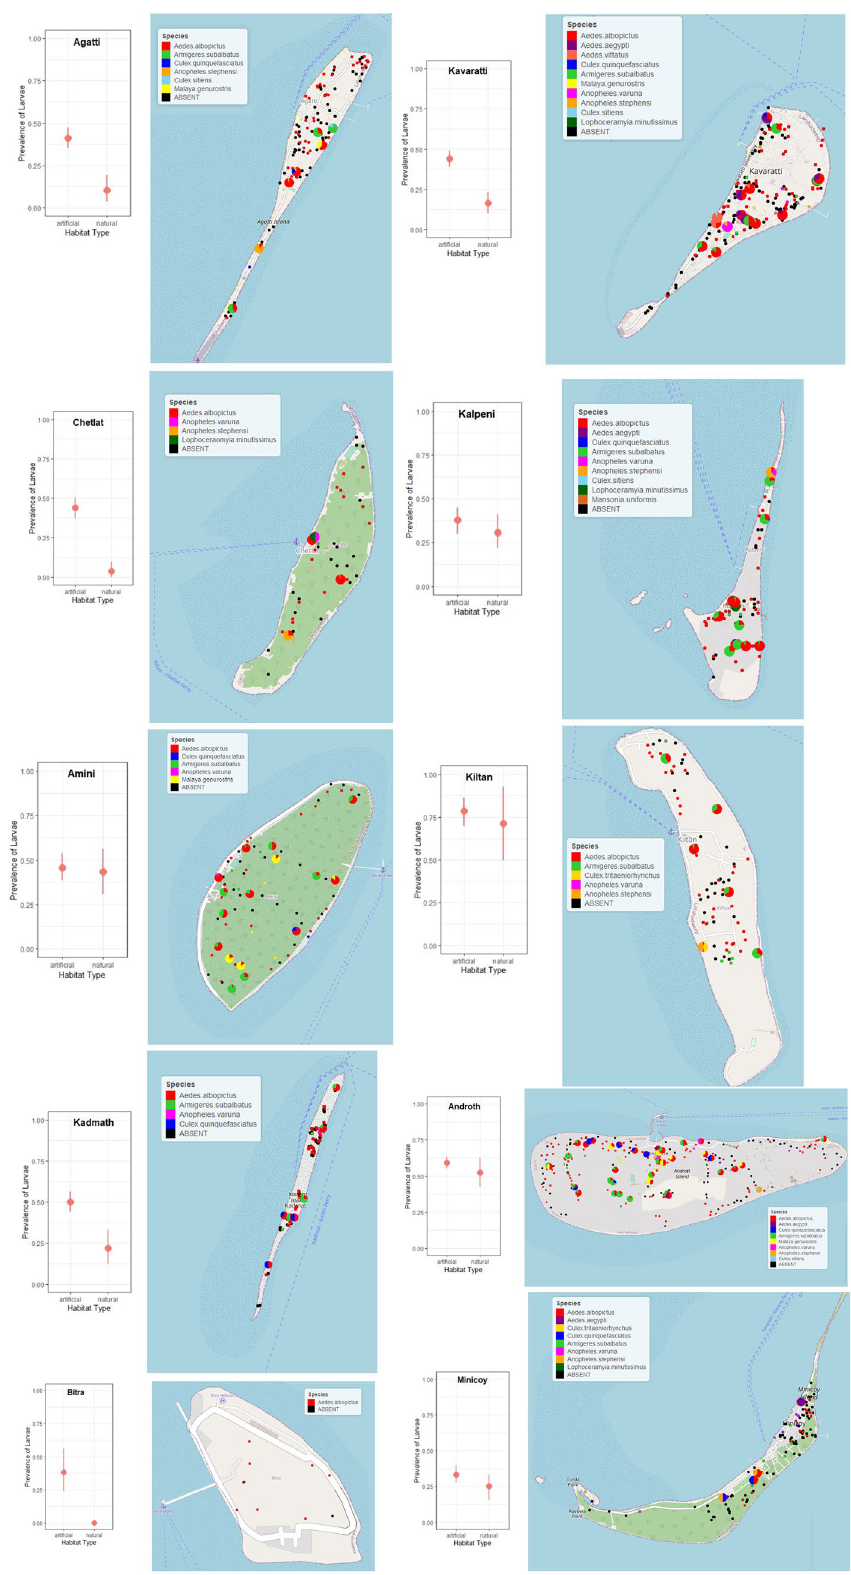
Figure 1. Mosquito larval survey sites shown in coloured dots on ten Lakshadweep Islands. The mean and 95% confidence interval bar show prevalence of artificial and natural habitats on each island. Maps produced using leaflet package in